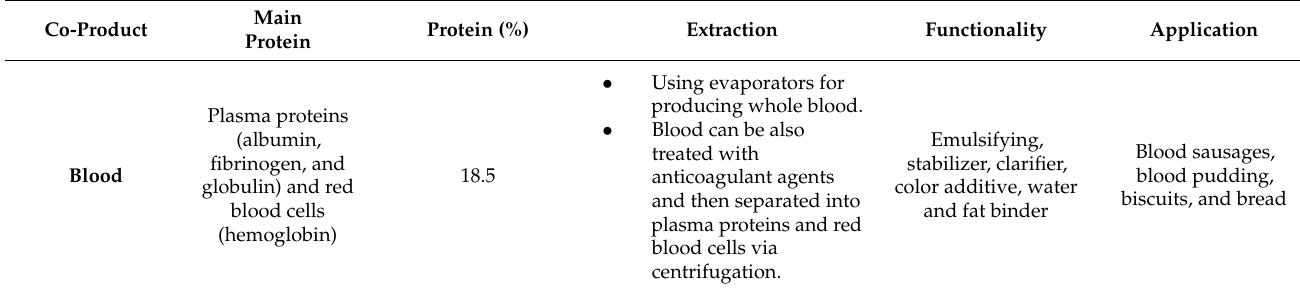
Figure 4. Different stages for protein’s recovery from animals processing co-products and secondary streams [64]. Table 1. Overview of the main proteins in some animal co-products.